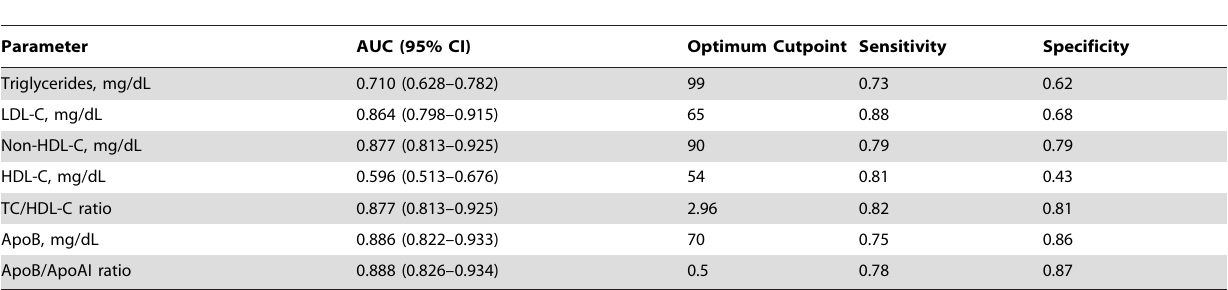
Table 3. Receiver operating characteristic curve analysis of selected predictors of achieving LDL-P , 1000 nmol/L target value.